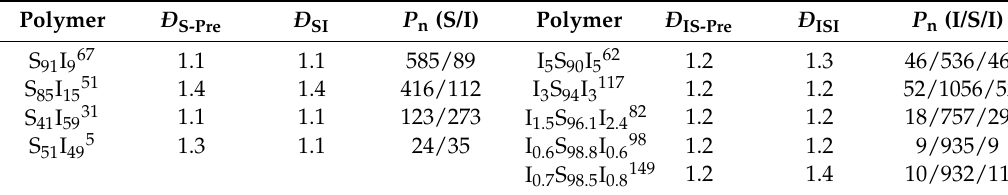
Table 1. Investigated di- and triblock copolymers and the dispersity indices of precursor Đ Pre as well as Đ poly of the resulting SI or ISI block copolymers. All Đ were determined from SEC measurements. PI-Precursors were not measured due to too low molecular weight. The degree of polymerization P n is given for the polystyrene (S) and polyisoprene (I) monomer